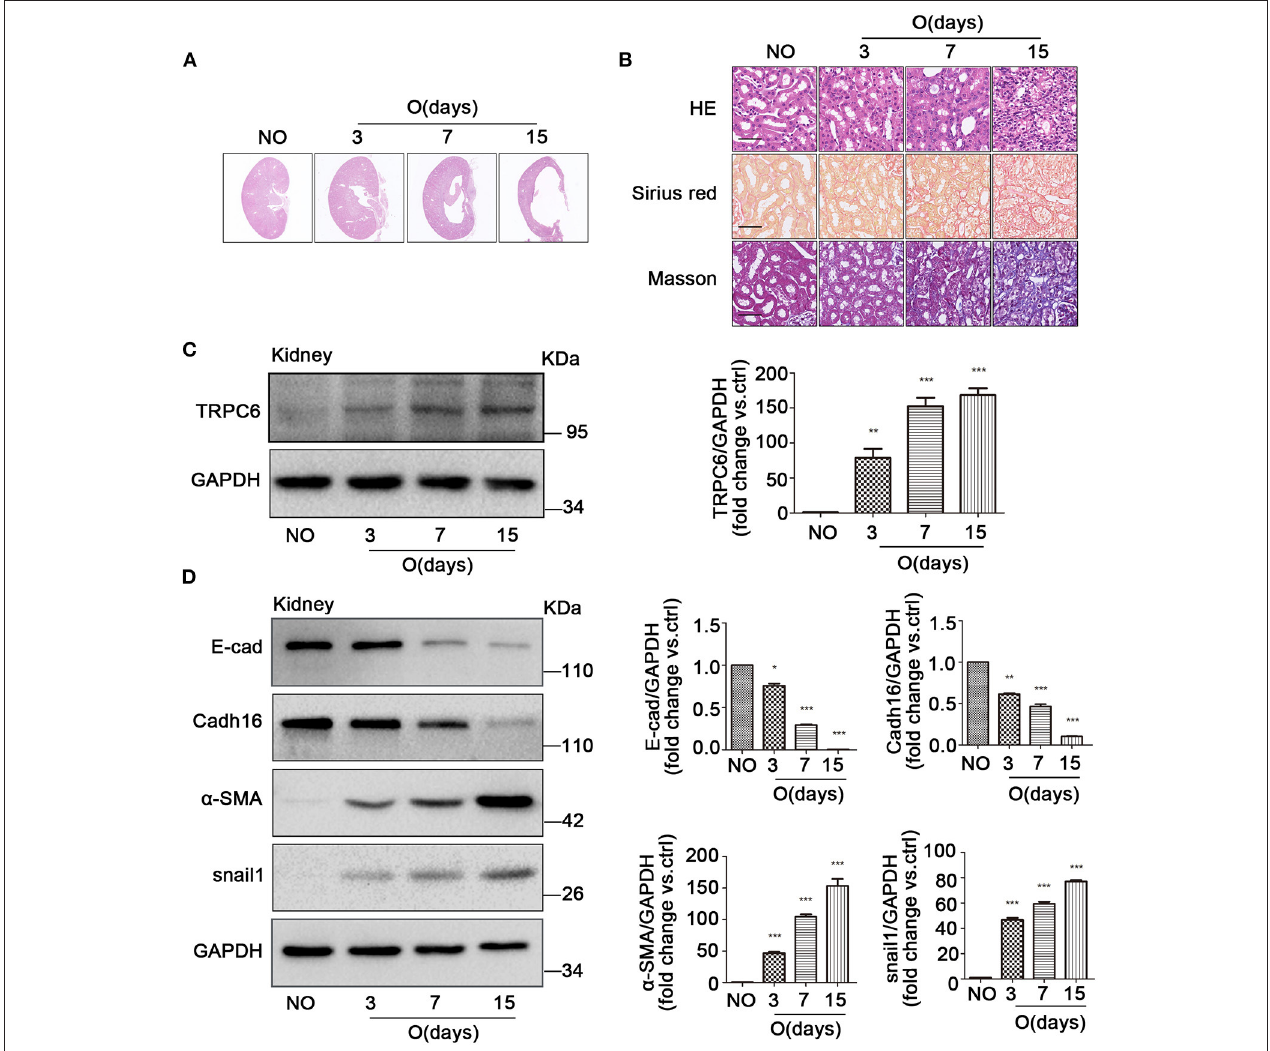
FIGURE 1 | The increase of TRPC6 and activation of EMT in fibrotic kidney tissues. (A) Representative scanning images of kidney coronal plane showing the cavity caused by fibrosis injury in the contralateral non-obstructed (NO) and obstructed (O) kidneys from WT mice on days 3, 7, and 15 after UUO. (B) Representative images of similar kidney sections stained by HE, Masson, and Sirius red showing the interstitial fibrosis change of kidney tissues from the above groups. Scale bars, 20 µ m. (C) Expression level of TRPC6 from the above groups detected by western blot. Data are presented as mean ± sem, n = 3; an unpaired two-tailed t -test was used. ** P < 0.01, *** P < 0.001. (D) Expression level of EMT markers E-cad, Cadh16, α -SMA, and snail1 from the above groups detected by western blot. Data are presented as mean ± sem, n = 3; an unpaired two-tailed t -test was used. * P < 0.05, ** P < 0.01, *** P <